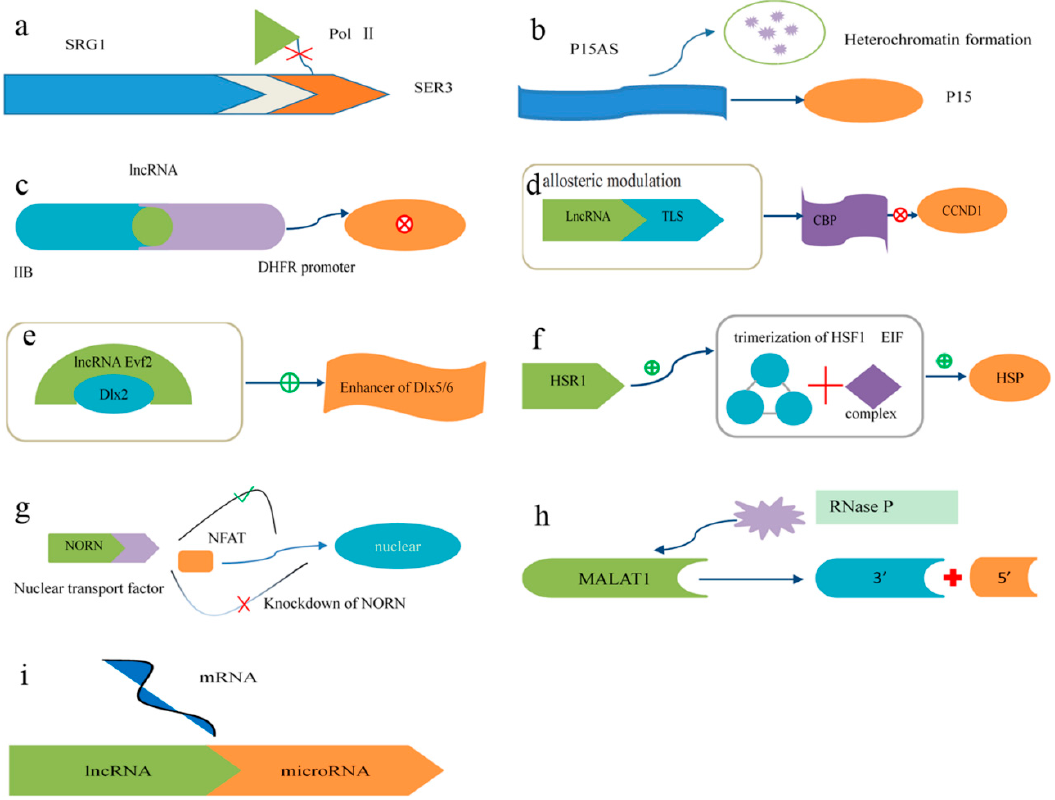
Figure 2. Mechanisms of lncRNA action in transcriptional regulation. ( a ) Transcription of the lncRNA SRG1 inhibits the expression of the SER3 gene by interfering with the binding of RNA polymerase II to DNA; ( b ) The expression of the p15 antisense RNA, the lncRNA of a tumor suppressor gene, results in the silencing of the p15 gene through the induction of heterochromatin formation, which persisted after the p15 antisense RNA was turned off; ( c ) lncRNA binds to the major DHFR promoter and IIB, a general transcriptional factor, to form a stable and specific complex to dissociate the preinitiation complex from the major DHFR promoter; ( d ) As a response to stress, the RNA-binding protein TLS, under allosteric modulation via lncRNA upstream of CCND1, binds to chromatin-binding protein (CBP) and inhibits CBP/P300 HAT activities on CCND1; ( e ) The lncRNA Evf2, a crucial co-enhancer of regulatory proteins involved in transcription, cooperates with the Dlx2 protein to activate the Dlx5/6 enhancer in a target gene; ( f ) In response to heat shock, the lncRNA HSR1 (heat shock RNA-1) promotes the trimerization of HSF1 (heat-shock transcription factor 1), and consequently the translation factor EIF interacts with HSR1 and HSF1 to forms a complex to facilitate the expression of heat-shock protein (HSP); ( g ) NFAT is nuclear factor of activated T cells. The lncRNA NRON (noncoding repressor of NFAT) may form a complex with importin proteins to regulate the subcellular localization of NFAT. The knockdown of NRON increases the expression and activity of NFAT; ( h ) The lncRNA metastasis-associated lung adenocarcinoma transcript 1(MALAT1) has been shown to be abnormally expressed in many human cancers. The nascent MALAT1 transcript is cleaved by RNase P to produce the 3 ′ end of the mature MALAT1 transcript and the 5 ′ end of the small RNA; ( i ) Several studies have elucidated that some lncRNAs can act as microRNA sponges to competitively bind to microRNAs and decrease microRNA-induced tumorsphere differentiation.